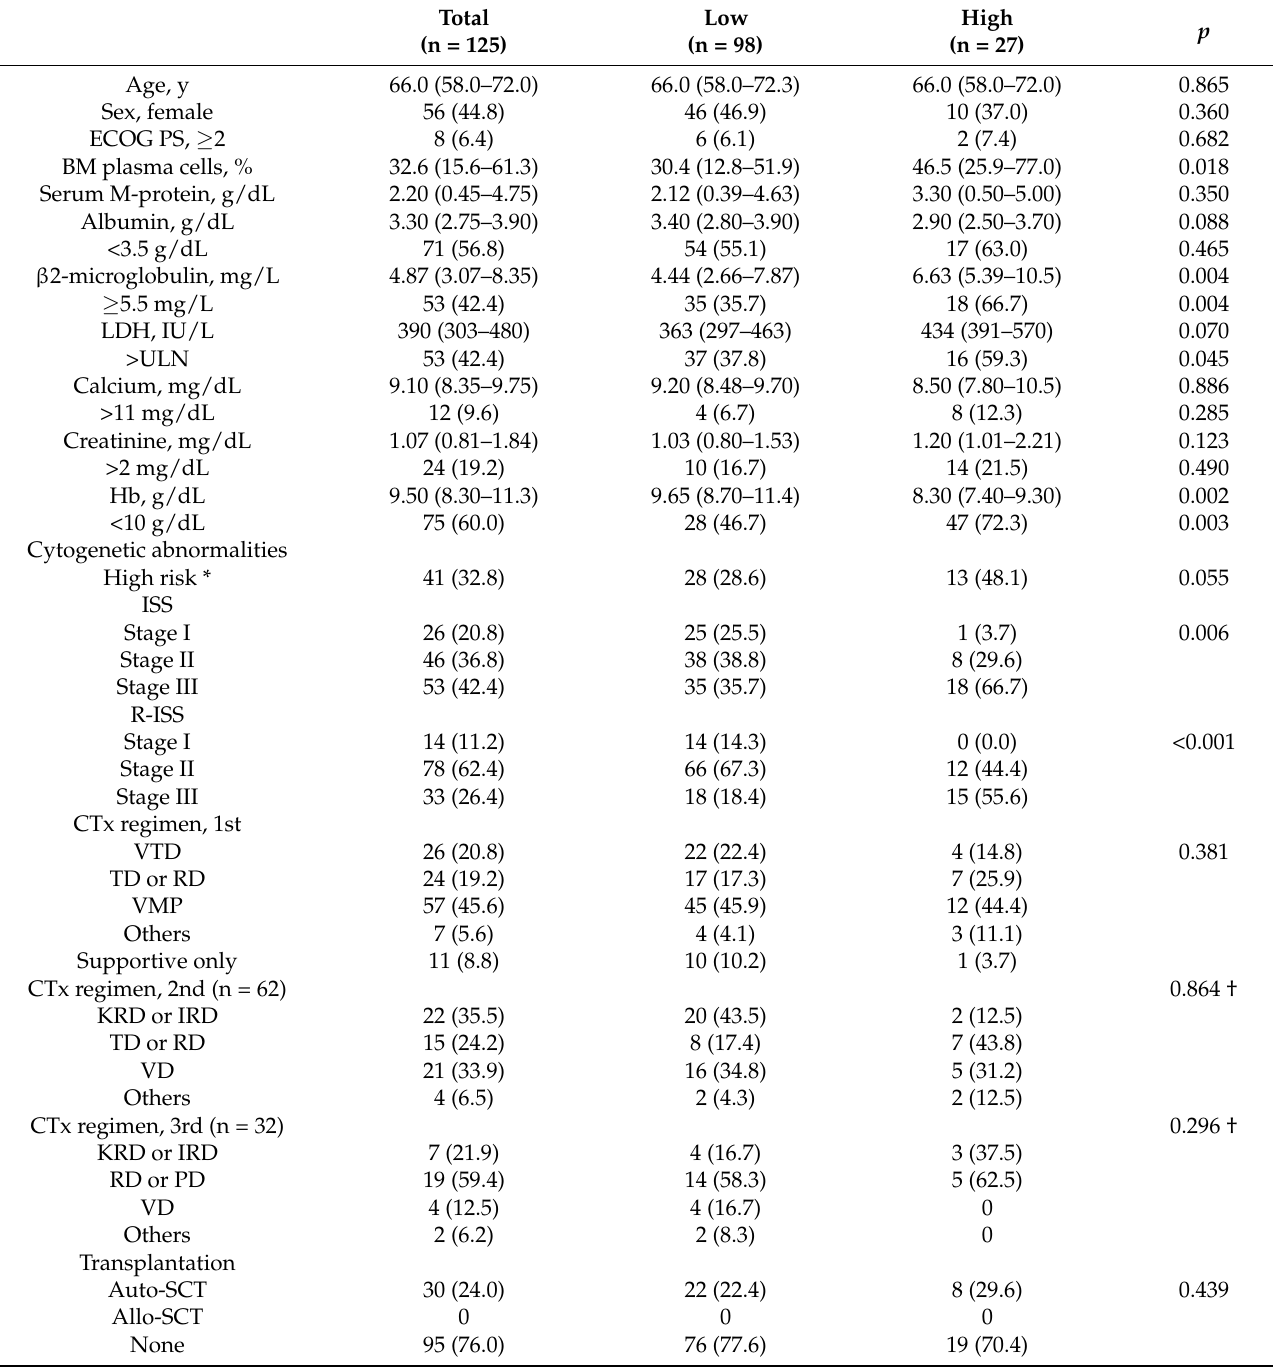
Table 2. Comparison of clinical factors between patients with low and high PVR